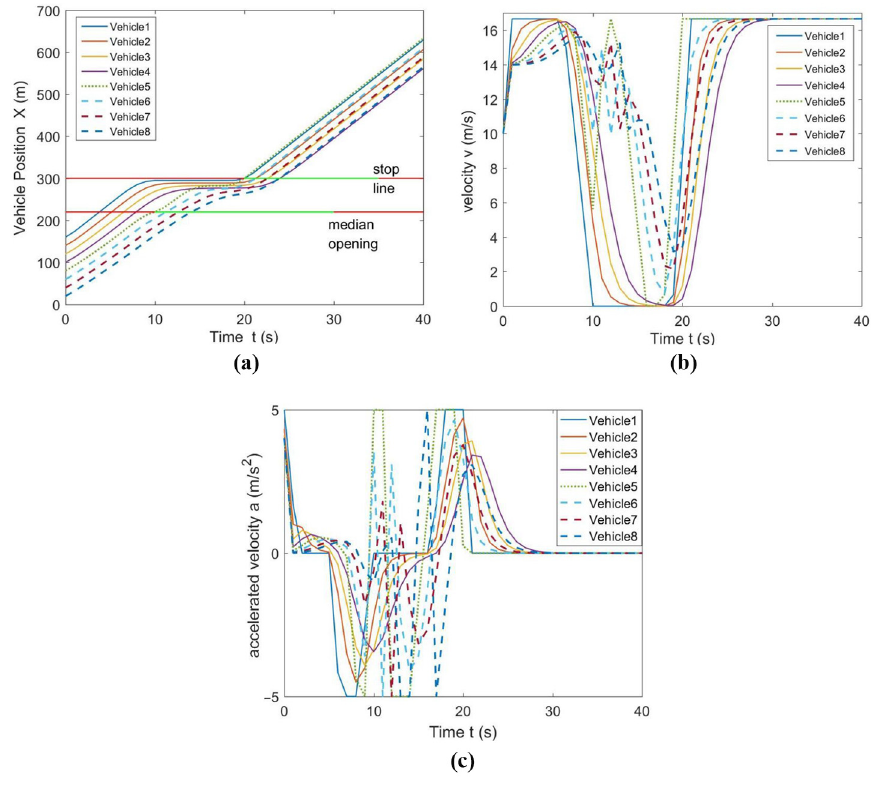
Figure 2 Trajectory planning